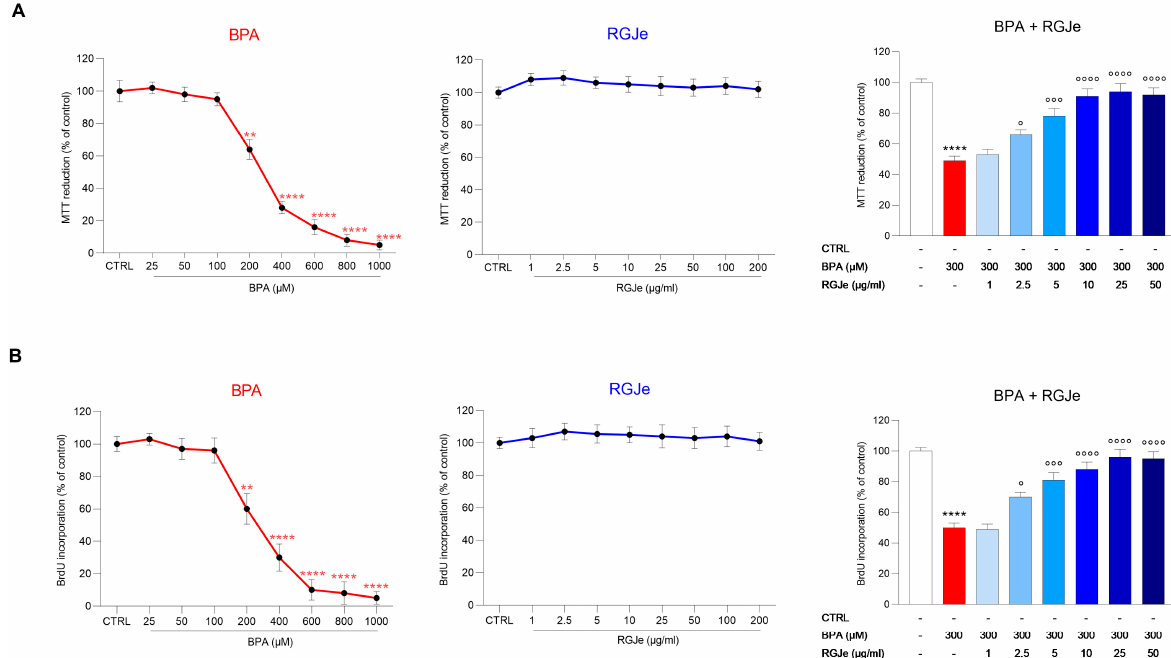
Figure 1. Protective effect of RGJe against BPA-induced cytotoxicity in HUVECs. Cell viability was evaluated by MTT test ( A ) and cell proliferation via BrdU incorporation test ( B ). Results of both assays are expressed as percentages ± SEM of the absorbance value detected in treated cells compared to untreated ones (control, CTRL). Three independent experiments in eight replicates were performed (n = 24). ** p < 0.01 and **** p < 0.0001 vs. CTRL; ◦ p < 0.05, ◦◦◦ p < 0.001, and ◦◦◦◦ p < 0.0001 vs. BPA 300 µ